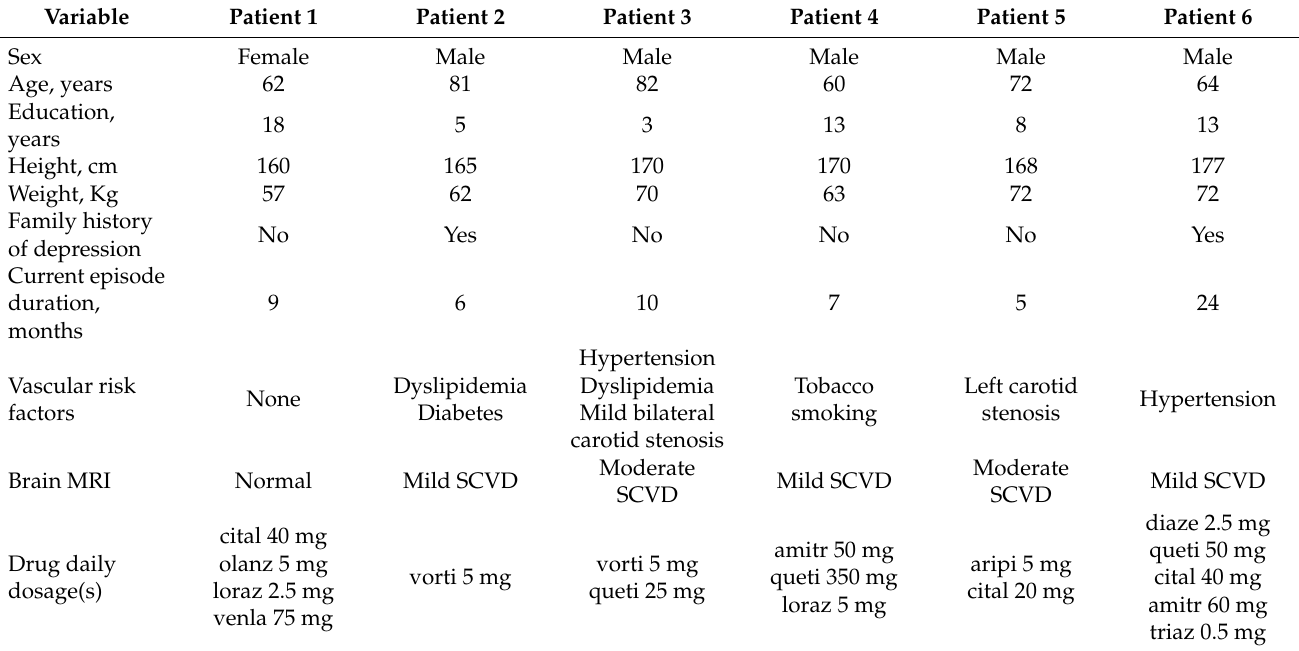
Table 1. Participants’ demographic and clinical features, along with the pharmacological